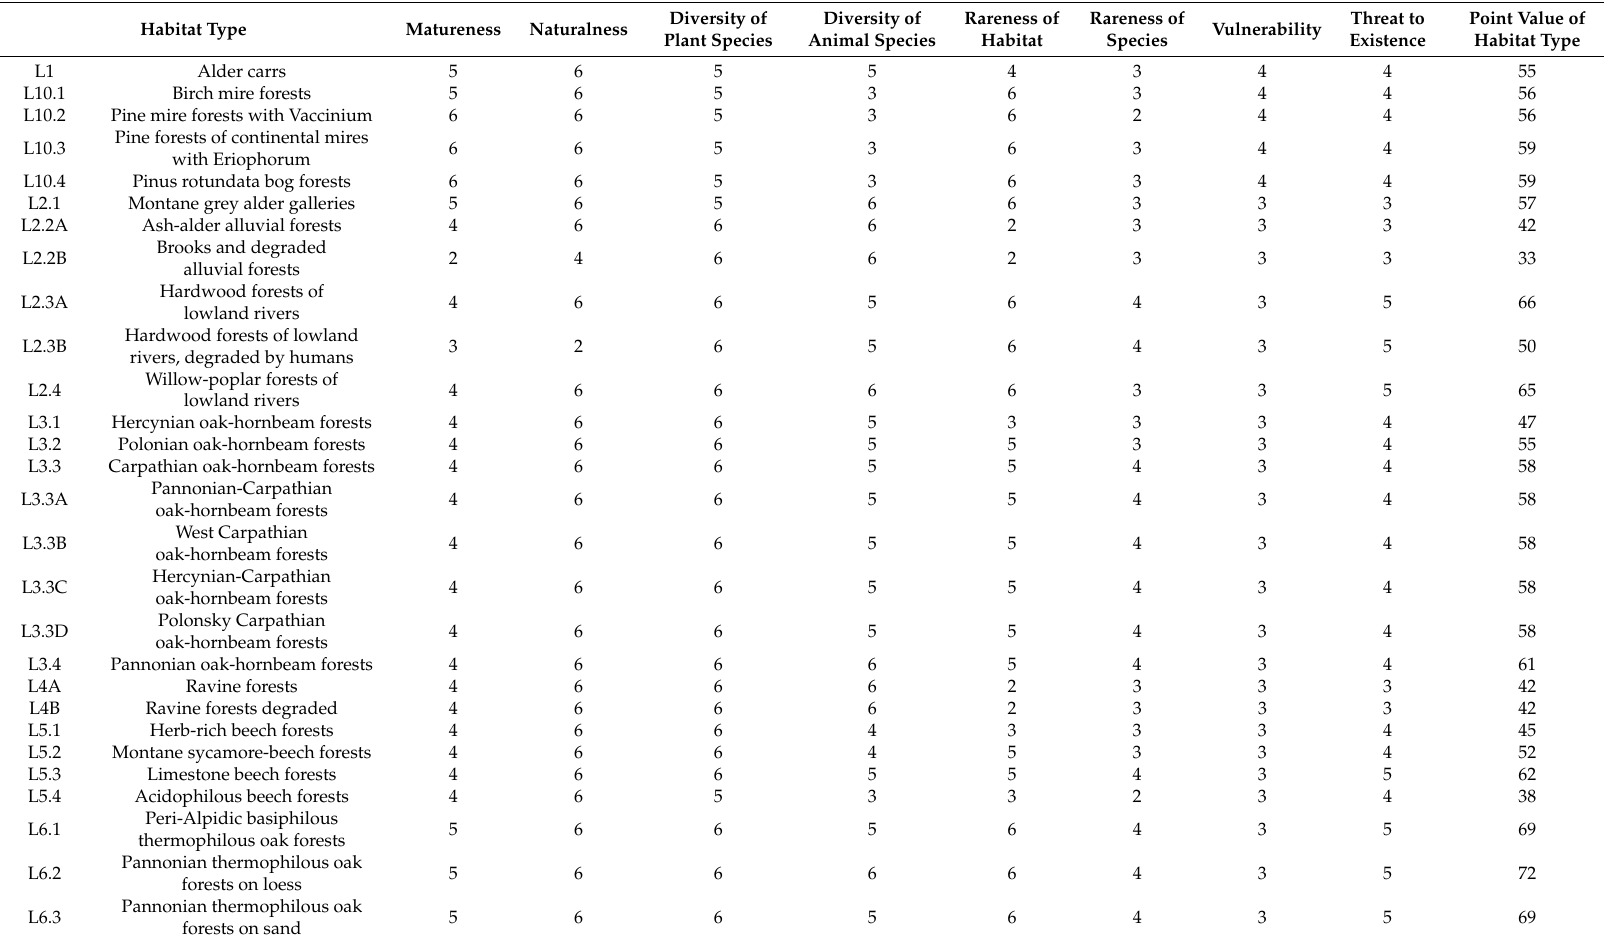
Table 1. Point values for natural forest habitat in the Czech